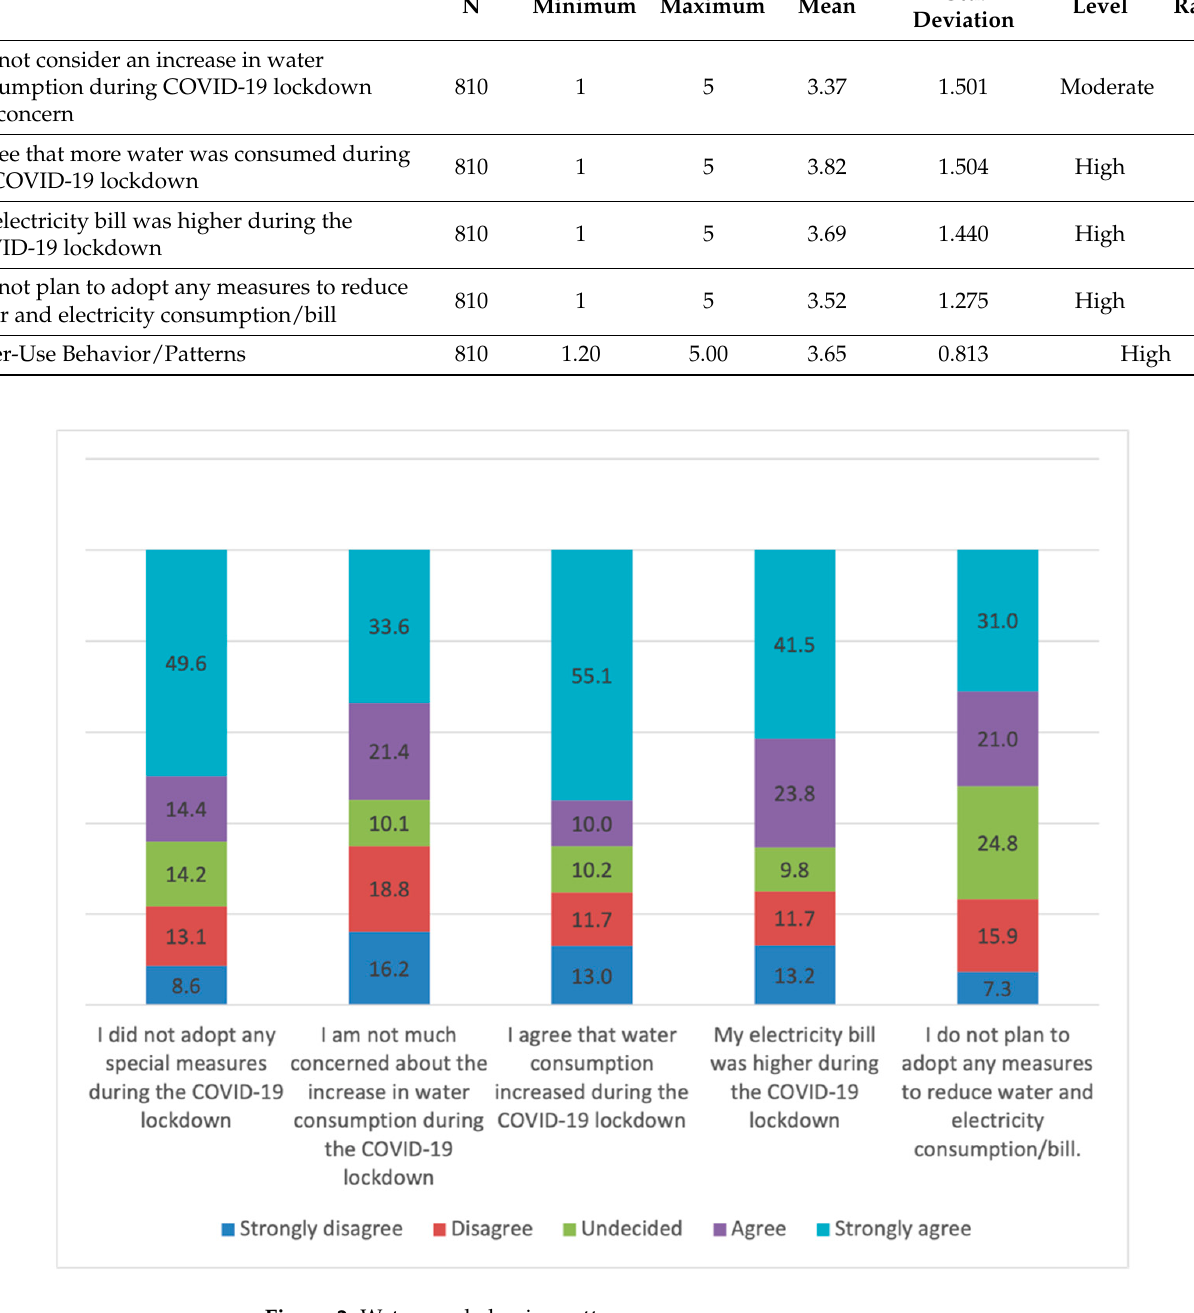
Figure 2. Water-use behavior patterns.